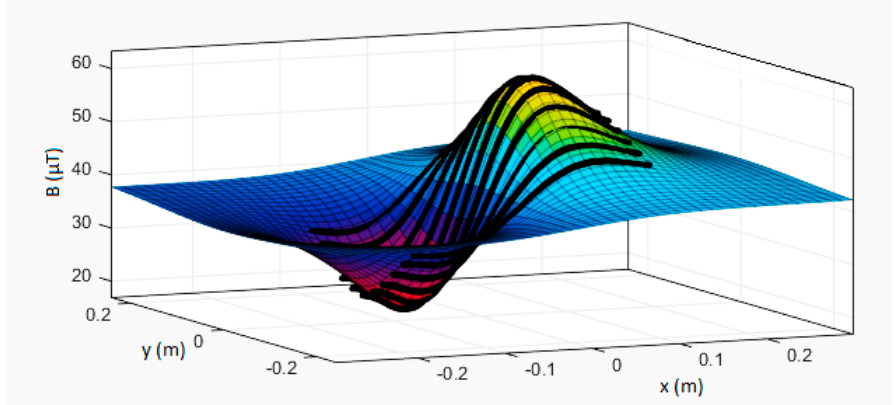
Figure 5. Approximation of ME8 induction of magnetic field distribution (black lines—measurement results) to the model (4). Coordinates set: ( x 0 , y 0 , z 0 ) = (0, 0, 140) mm, β = 0°, and φ = 90°. Three-dimensional graph of the distribution of B field values. The plane of the background field is inclined due to the gradient of the magnetic field—the heterogeneity of the background field. The method allowed us to determine the distance from the standard with an uncertainty of